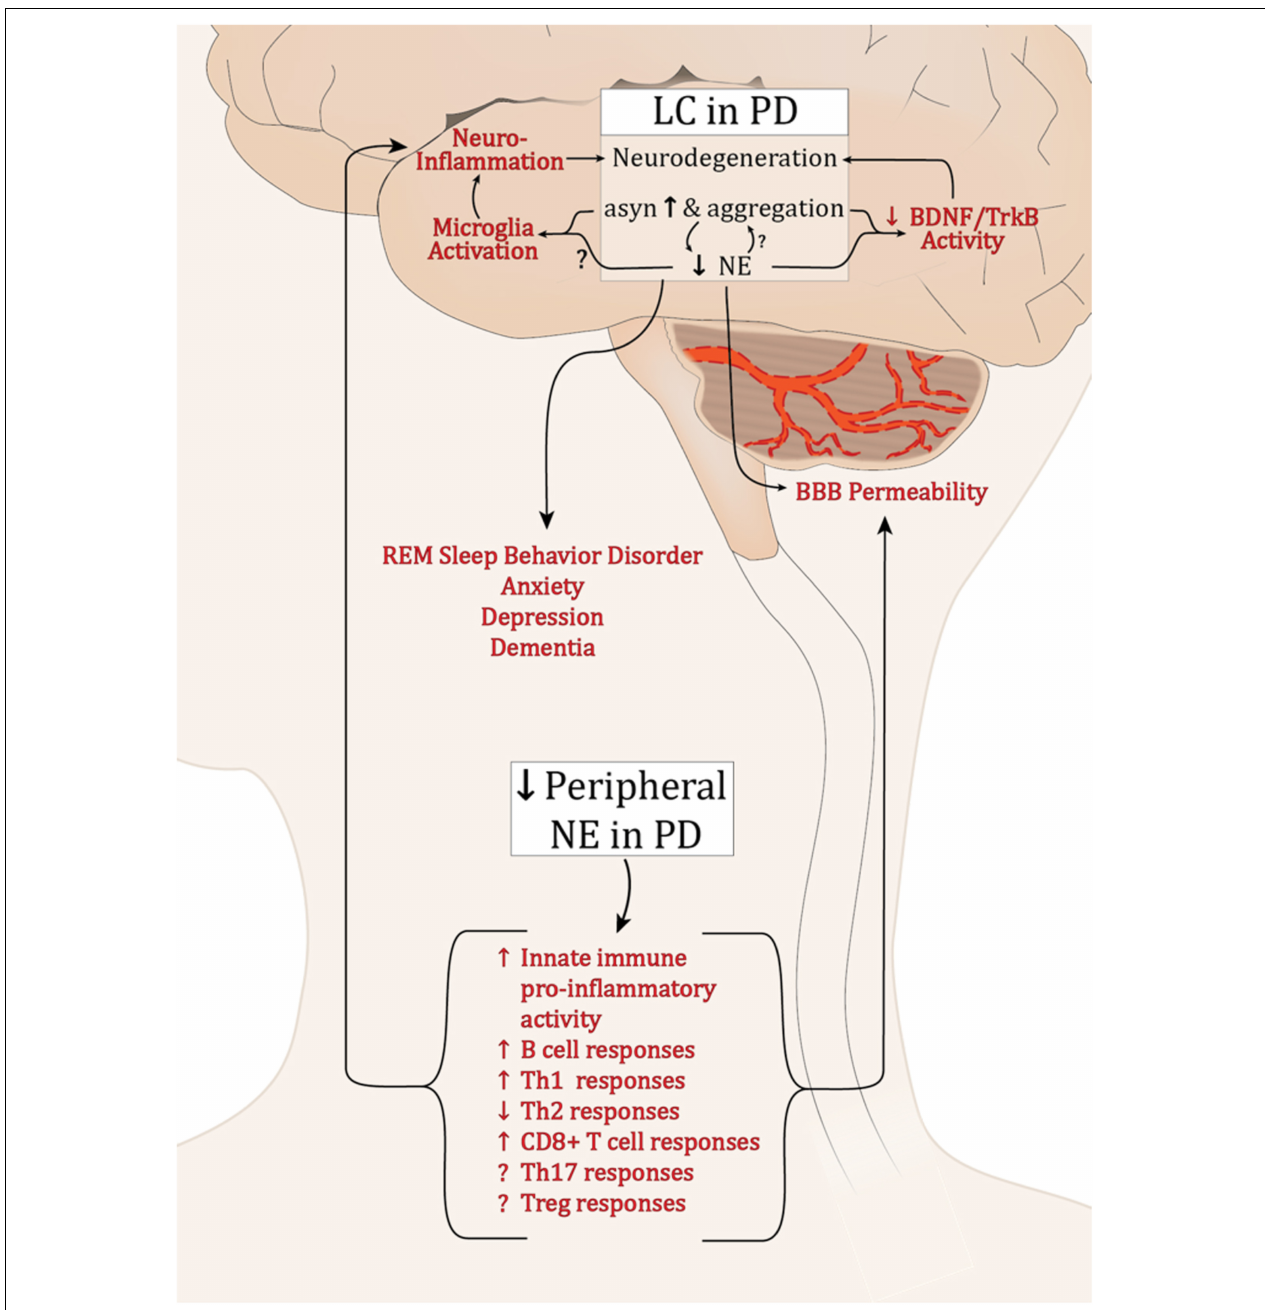
FIGURE 1 | Potential effects of dysregulated NE in PD. Abbreviations: α -syn, α -synuclein; BBB, blood brain barrier; B cell, B lymphocytes; BDNF, brain derived neurotrophic factor; LC, locus coeruleus; PD, Parkinson’s disease; NE, norepinephrine; Th1, T helper 1 lymphocytes; Th17, IL-17 producing T helper lymphocytes; Th2, T helper 2 lymphocytes; CD8+, cytotoxic T lymphocytes; Treg, T regulatory lymphocytes; Trkb, tropomyosin-related kinase B